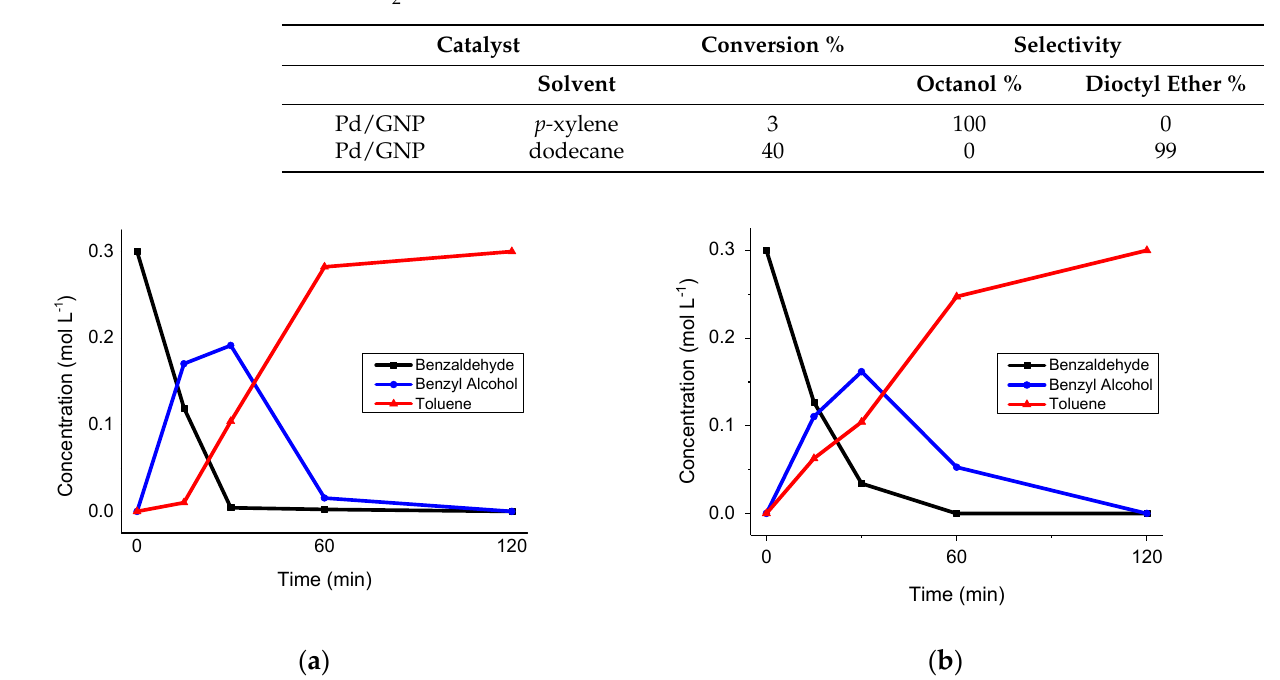
Figure 10. Benzaldehyde hydrogenation/hydrogenolysis reaction in p- xylene ( a ) or in dodecane ( b ). Reaction conditions: 50 °C, 2 bar of H 2 , substrate-to-metal ratio 1000:1, benzaldehyde 0.3 mol L − 1 in p- xylene.